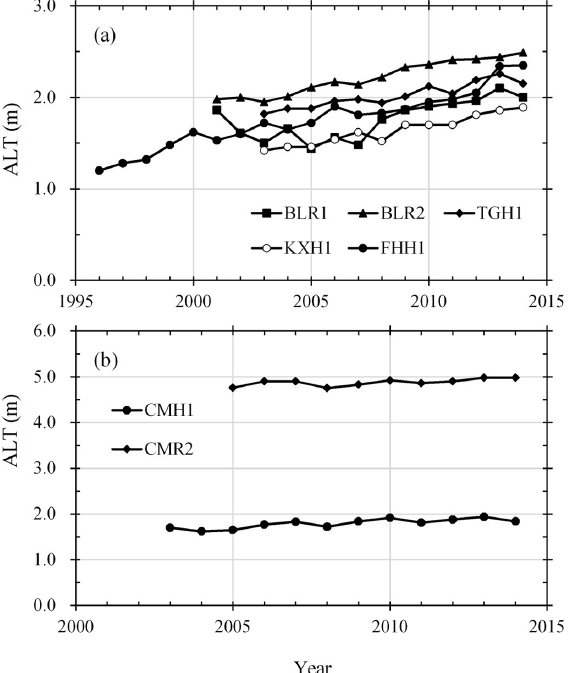
Figure 2. Active-layer thickness (ALT) beneath natural surface in alpine meadow (a) and alpine steppe (b) .